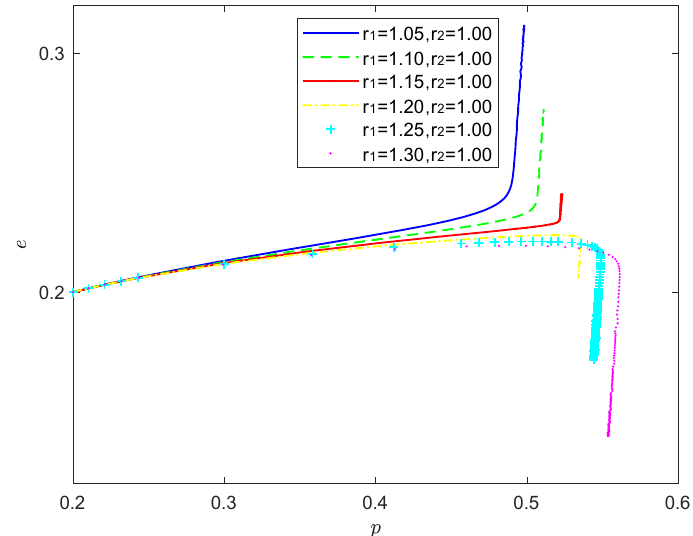
Figure 9. Evolution of game strategy in (pessimistic, rational) state.